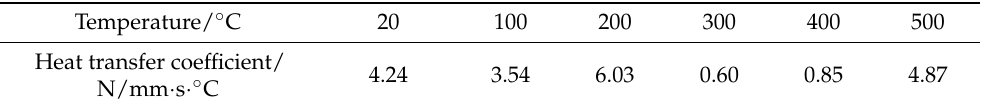
Table 7. Heat transfer coefficient values obtained in the third simulation.